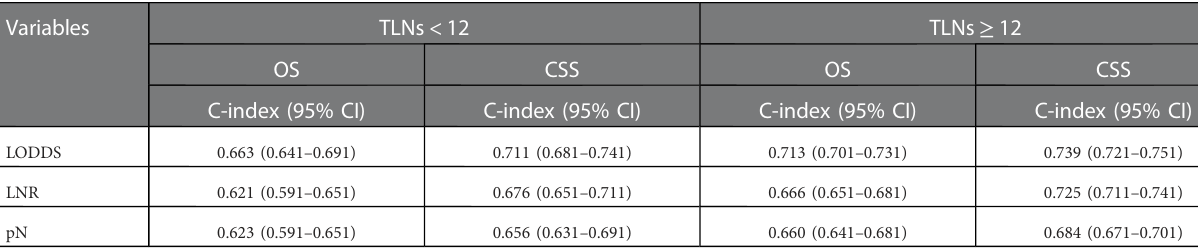
TABLE 4 Prognostic ef fi cacy of pN stage, LNR, and LODDS in the OS and CSS of colorectal SRCC patients based on retrieved lymph nodes. Variables